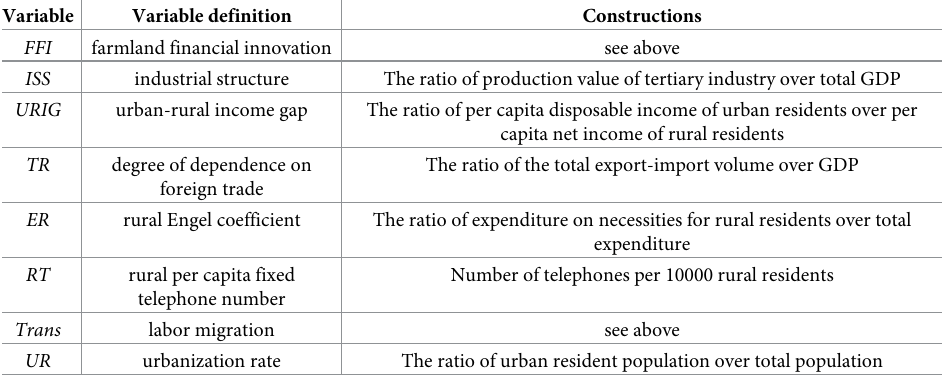
Table 3. Variable definition and